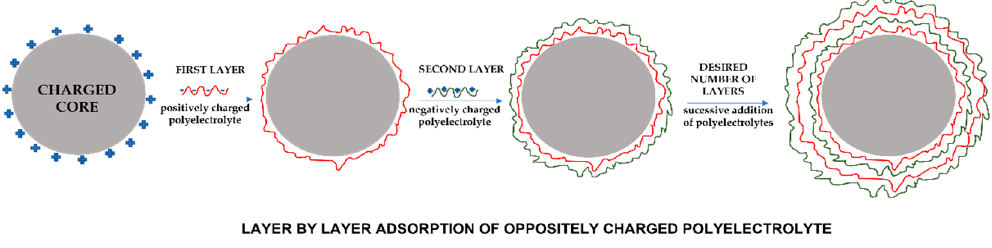
Figure 17. Layer ‐ by ‐ layer (LbL) self ‐ assembly microcapsules (adapted from [197]). Figure 17. Layer-by-layer (LbL) self-assembly microcapsules (adapted from